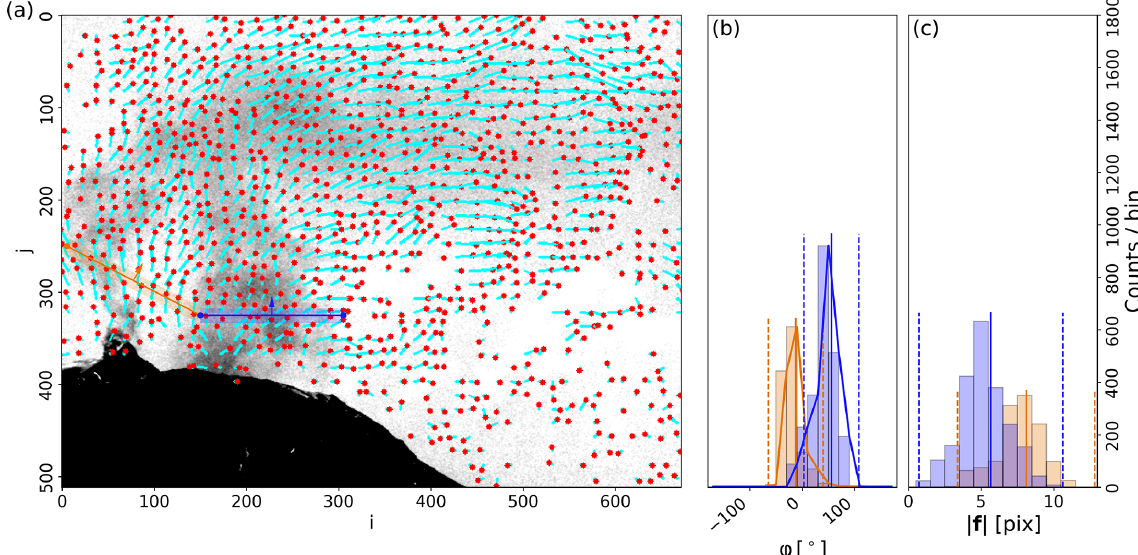
Figure 8. (a) Example output of the Farnebäck optical flow algorithm for the Guallatiri emissions at 14:48UTC including the two example PCS lines (blue/orange line) and the corresponding ROIs. (b, c) Histograms of magnitudes M ϕ and orientation angles M | f | used to retrieve the expectation intervals I ϕ and I | f | and the corresponding PDV in each ROI (cf. Eq. 5). From the latter, effective velocities of v eff = ( 3 . 1 ± 0 . 5 ) ms − 1 (crater, orange) and v eff = ( 1 . 8 ± 0 . 6 ) ms − 1 (fumaroles, blue) were retrieved. Note that in the left image (1) vectors shorter than 1.5pixels are excluded, (2) the displayed vector lengths were extended by a factor of 2, and (3) and only every 15th pixel of the DVF is displayed.